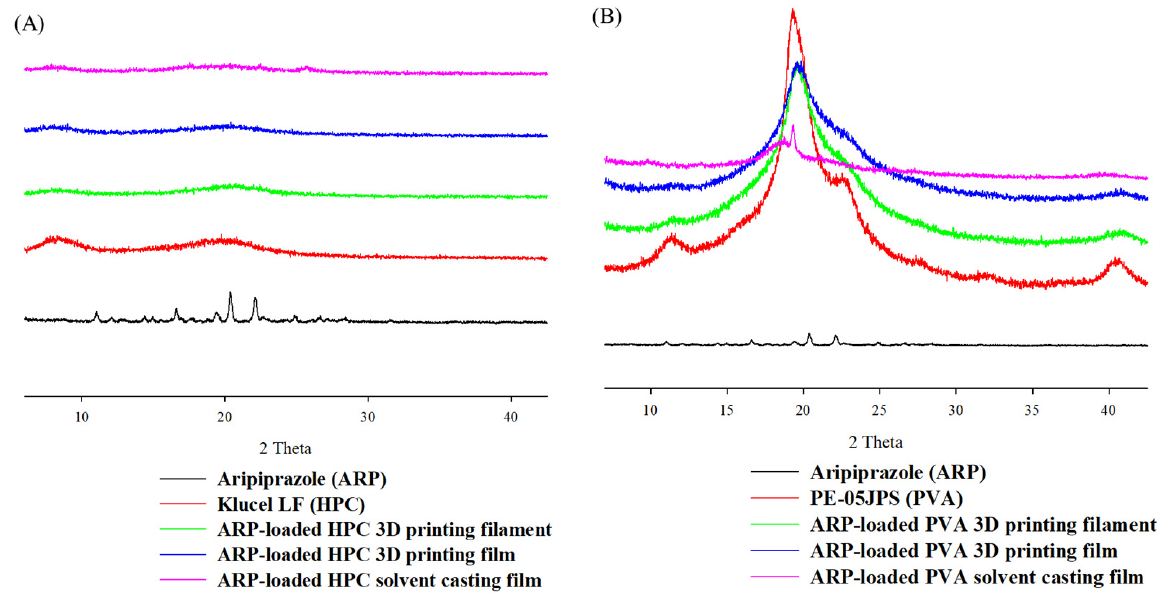
Figure 3. X-ray diffraction patterns of the aripiprazole formulations in ( A ) hydroxypropyl cellulose polymer and ( B ) polyvinyl alcohol polymer.